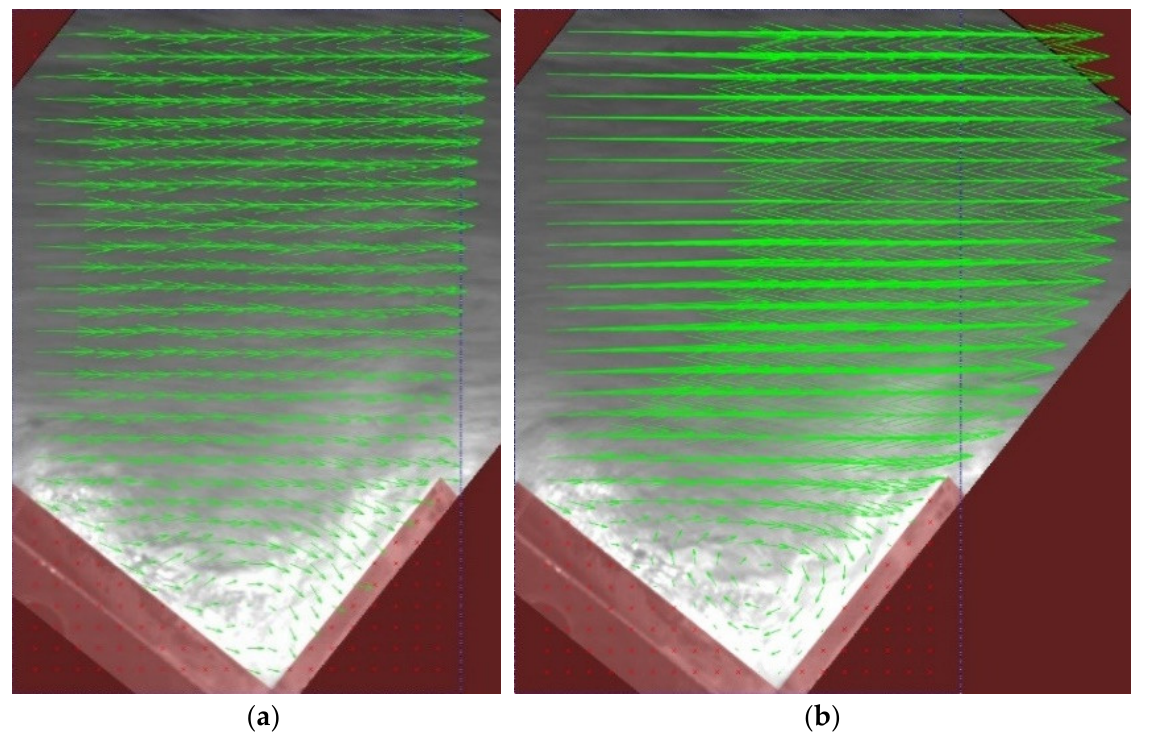
Figure 10. Average velocity field obtained at L / L t = 0.49 for d c / h = 2.38 and ( a ) 200 fps ( b ) 400 fps, when reducing the interrogation area in 3 steps from 288 to 144, then to 72, and then to 36 pixels. These discrepancies in the results as a function of the image acquisition rate show that 200 fps will not be adequate for the phenomenon to be studied. In Figure 12, the correlation and coefficient of variation ( C v ) obtained for both 400 fps and 200 fps are shown. The velocity fields obtained with an acquisition rate of 200 fps are poorly represented due to the lower correlation and higher coefficient of variation. For this reason, recordings made on lateral view at 200 fps were subsequently